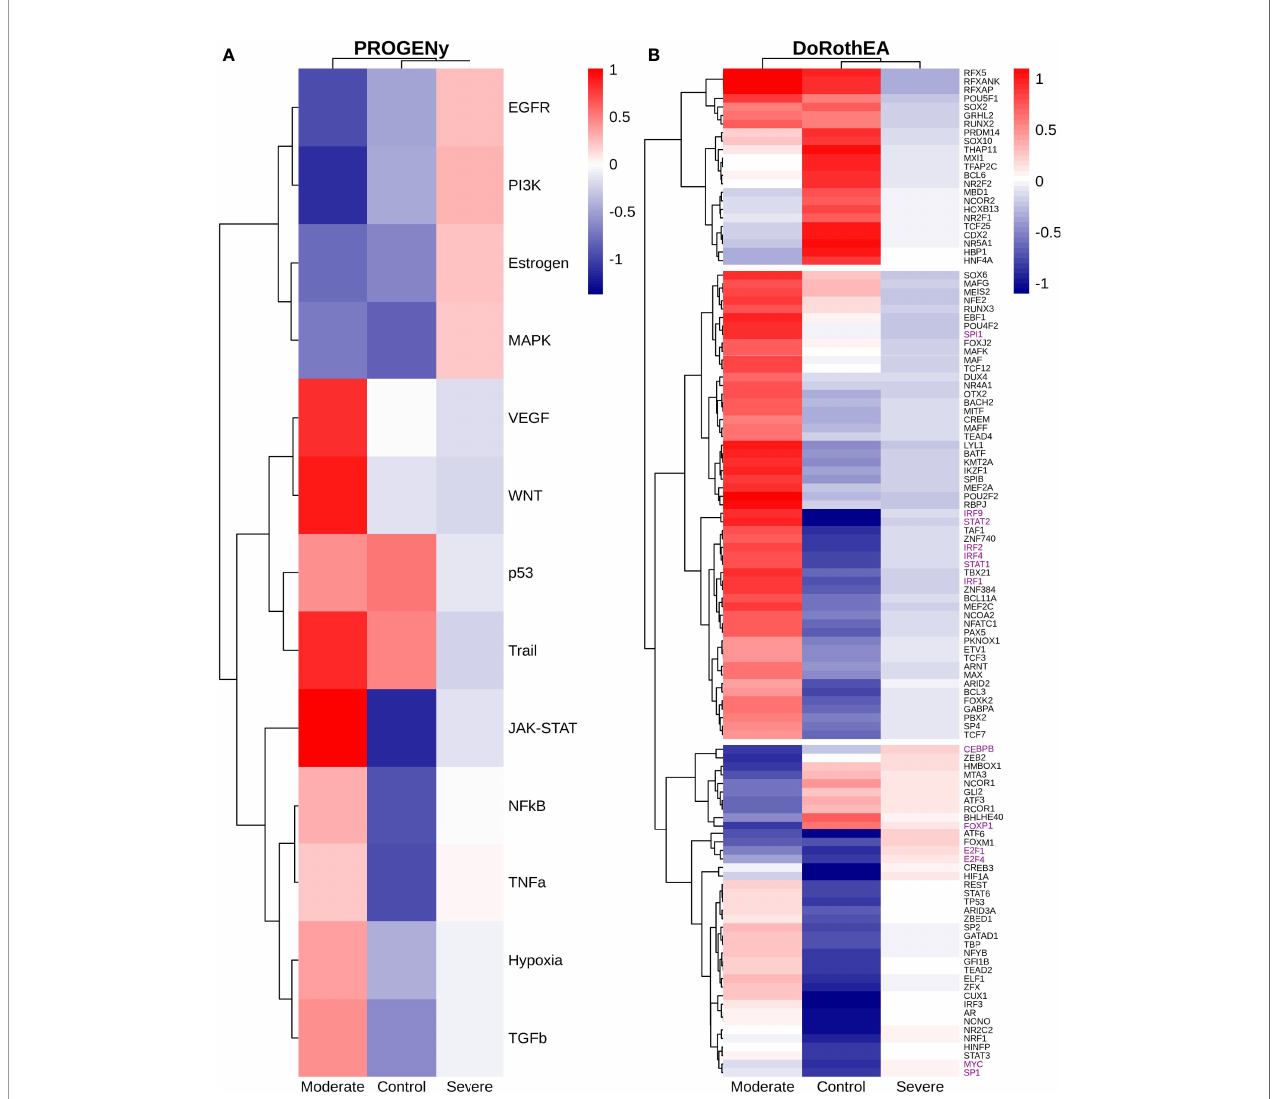
FIGURE 11 | TFs associated with the disease severity in B cells. (A) Resulting Heatmap from DoROthEA analysis. (B) Resulting Heatmap from PROGENy analysis. Colorbar sets the activation (red) and inactivation (blue)